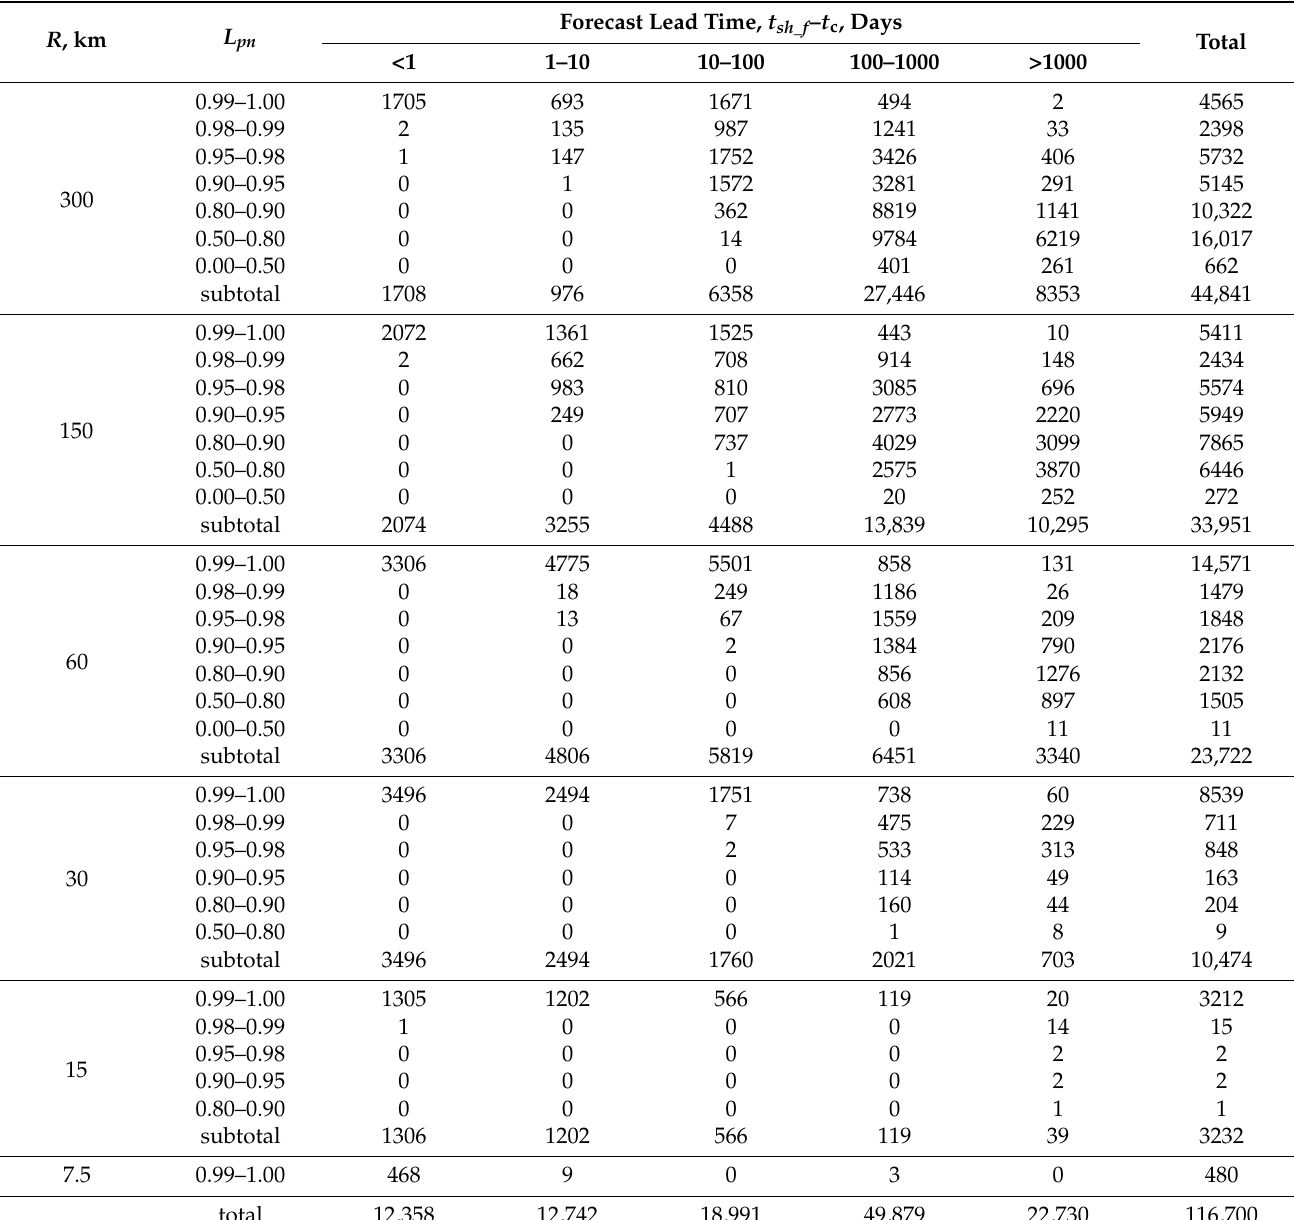
Table A2. Distribution of the precedents of foreshock retro-forecasts depending on the sample radius R , predictive nonlinearity L pn and forecast lead